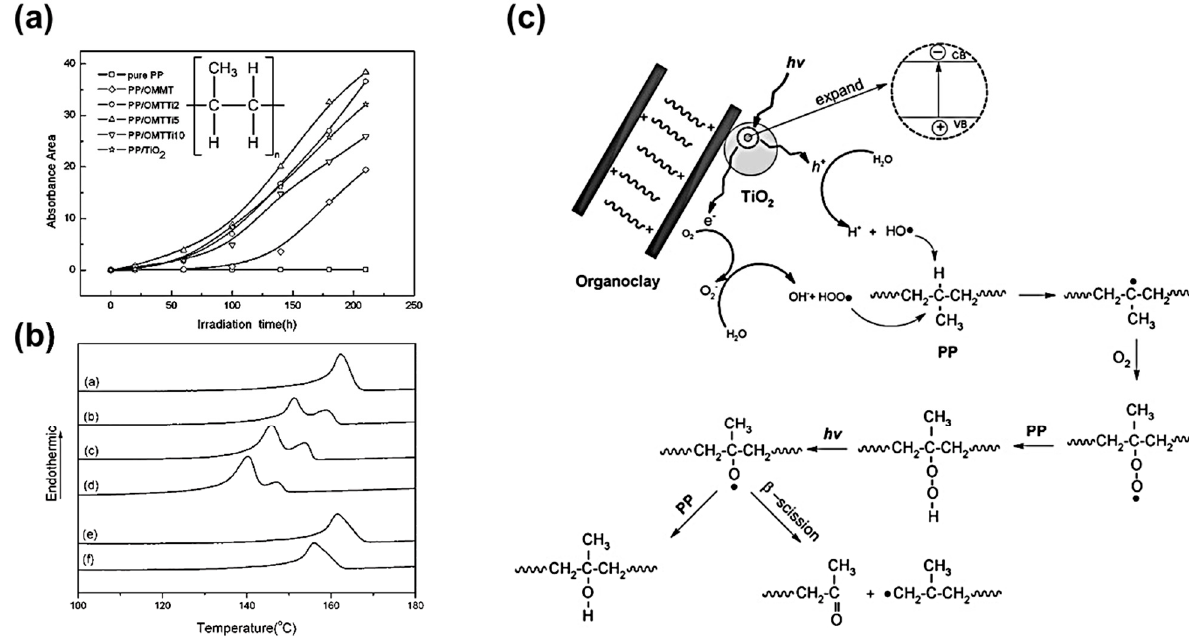
Figure 12. Photodegradation of PP. ( a ) Irradiation time dependent carbonyl band area of composite of pure PP, PP/OMMT, PP/OMTTi2, PP/OMTTi5, PP/OMTTi10, and PP/TiO 2 . Inset: Chemical formula of PP. ( b ) Melting endotherms of PP/OMTTi5 film irradiated for 0 h (curve A), 80 h (curve B), 170 h (curve C), 300 h (curve D), as well as that of pure PP film irradiated for 0 h (curve E) and 300 h (curve F). ( c ) Proposed mechanism for degradation of PP/TiO 2 -OMT composite [68]; reprinted from [68] with permission from John Wiley and Sons.